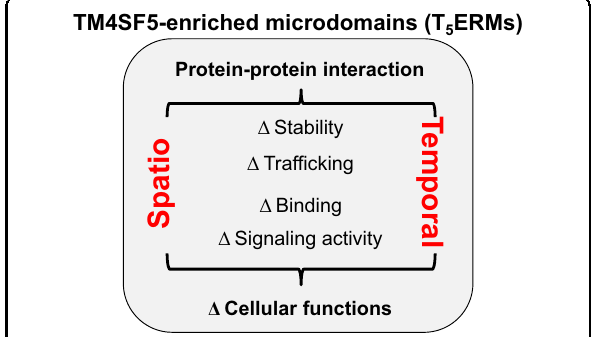
Fig. 1 Biological roles of TM4SF5-enriched microdomains (T 5 ERMs) on membranes. Within the T 5 ERMs, TM4SF5 can form massive protein-protein complexes with amino acid transporters, growth factor receptors, integrins, and other tetraspanins. TM4SF5 can thereby affect the expression/stability, traf fi cking/translocation, binding, and/or signaling activity of binding partners in a spatiotemporal manner, leading to changes in cellular functions during homeostasis or pathological